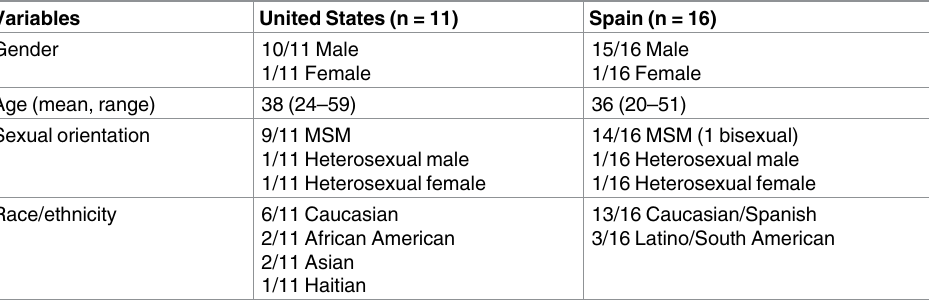
Table 1. Select demographic and behavioral characteristics of trial participants (n =